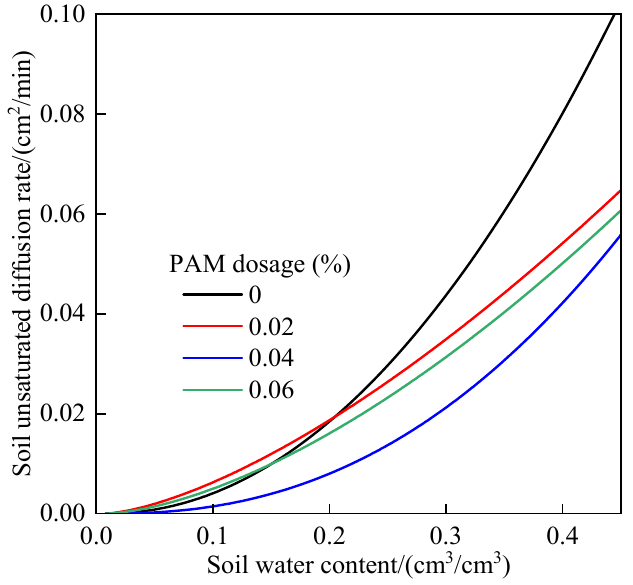
Figure 5. Soil unsaturated water diffusion rate under different PAM dosages.